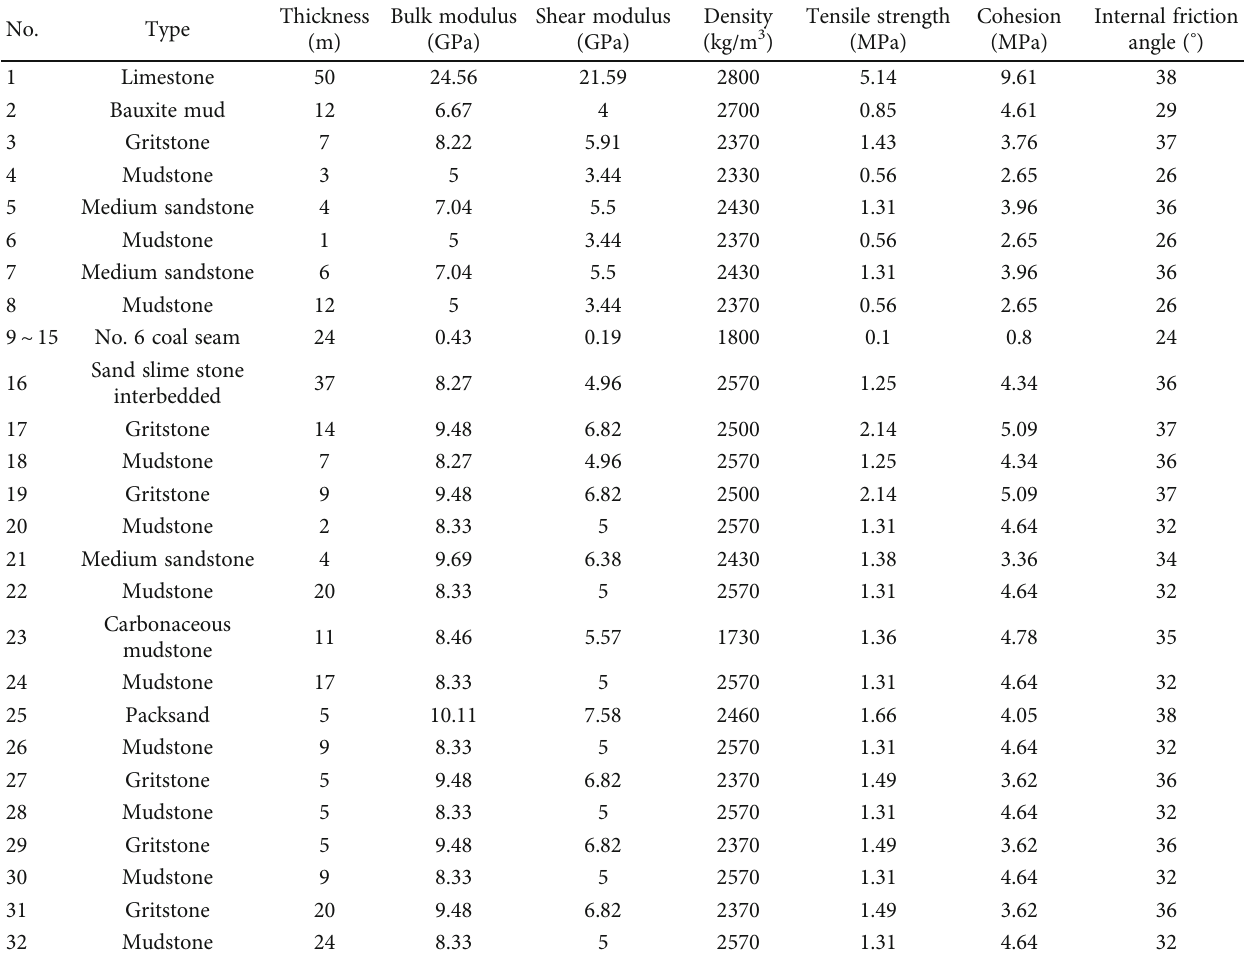
Table 1: Physical and mechanical parameters of each